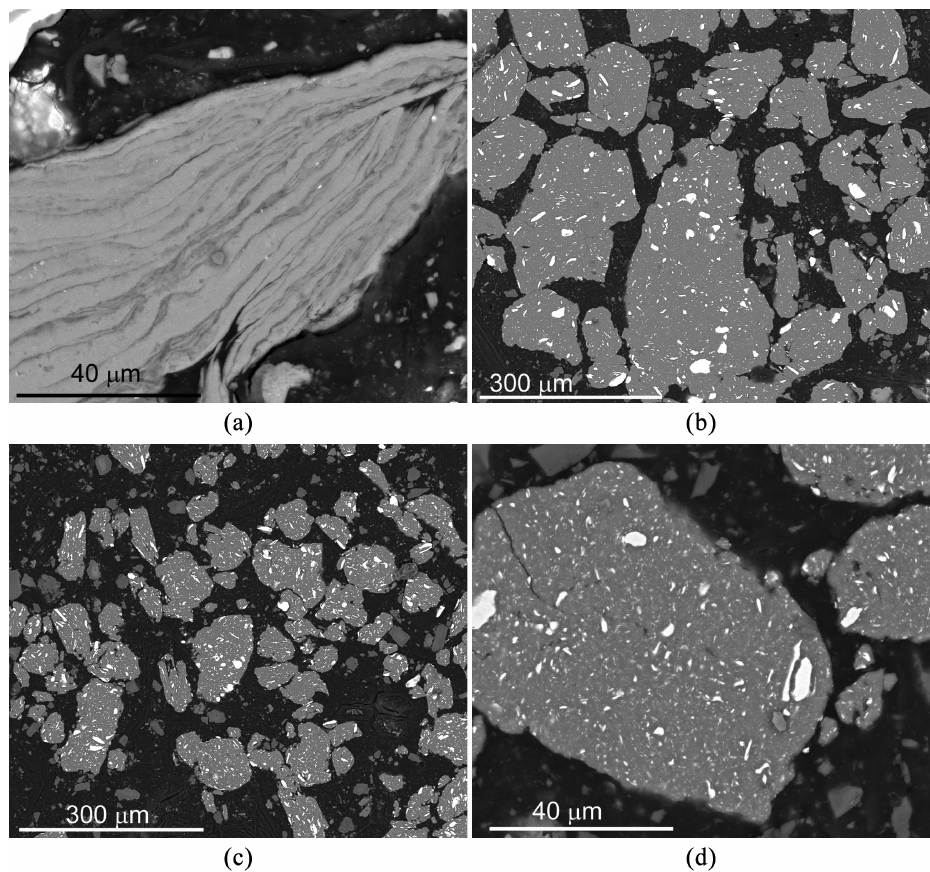
Figure 1. SEM micrographs obtained by back scattered electrons. (a) Al_5 vol.%MA956 milled for 2.5 h; (b) Al_5 vol.% MA956 milled for 20 h; (c) Al_10 vol.% MA956 milled for 20 h; (d) Al_10 vol. % MA956 milled for 50